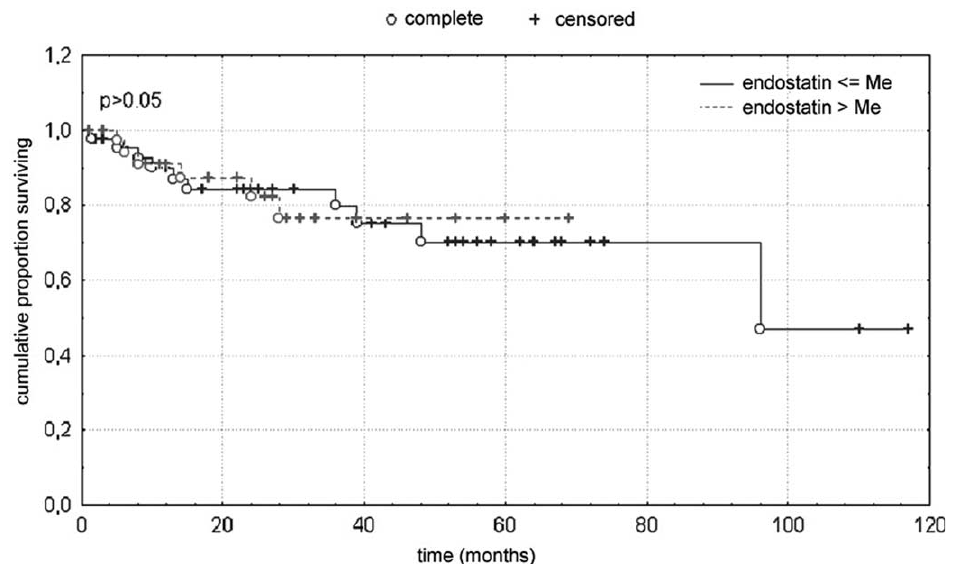
FIG. 2. The probability of survival for MM patients with high and low ( (cid:1) / median and B / median) concentrations of